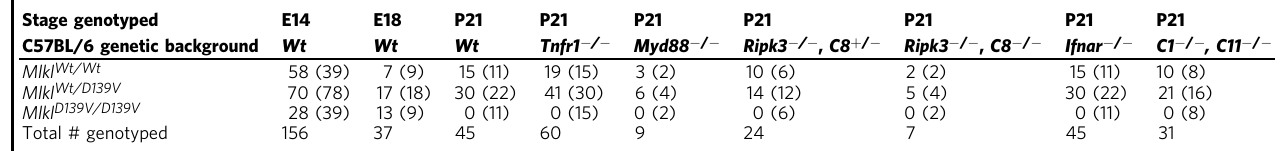
() - number of pups expected from Mendelian segregation, calculated from total number of pups genotyped and rounded to the nearest whole number. Gene names italicized. E, embryonic day; P, days postnatal.